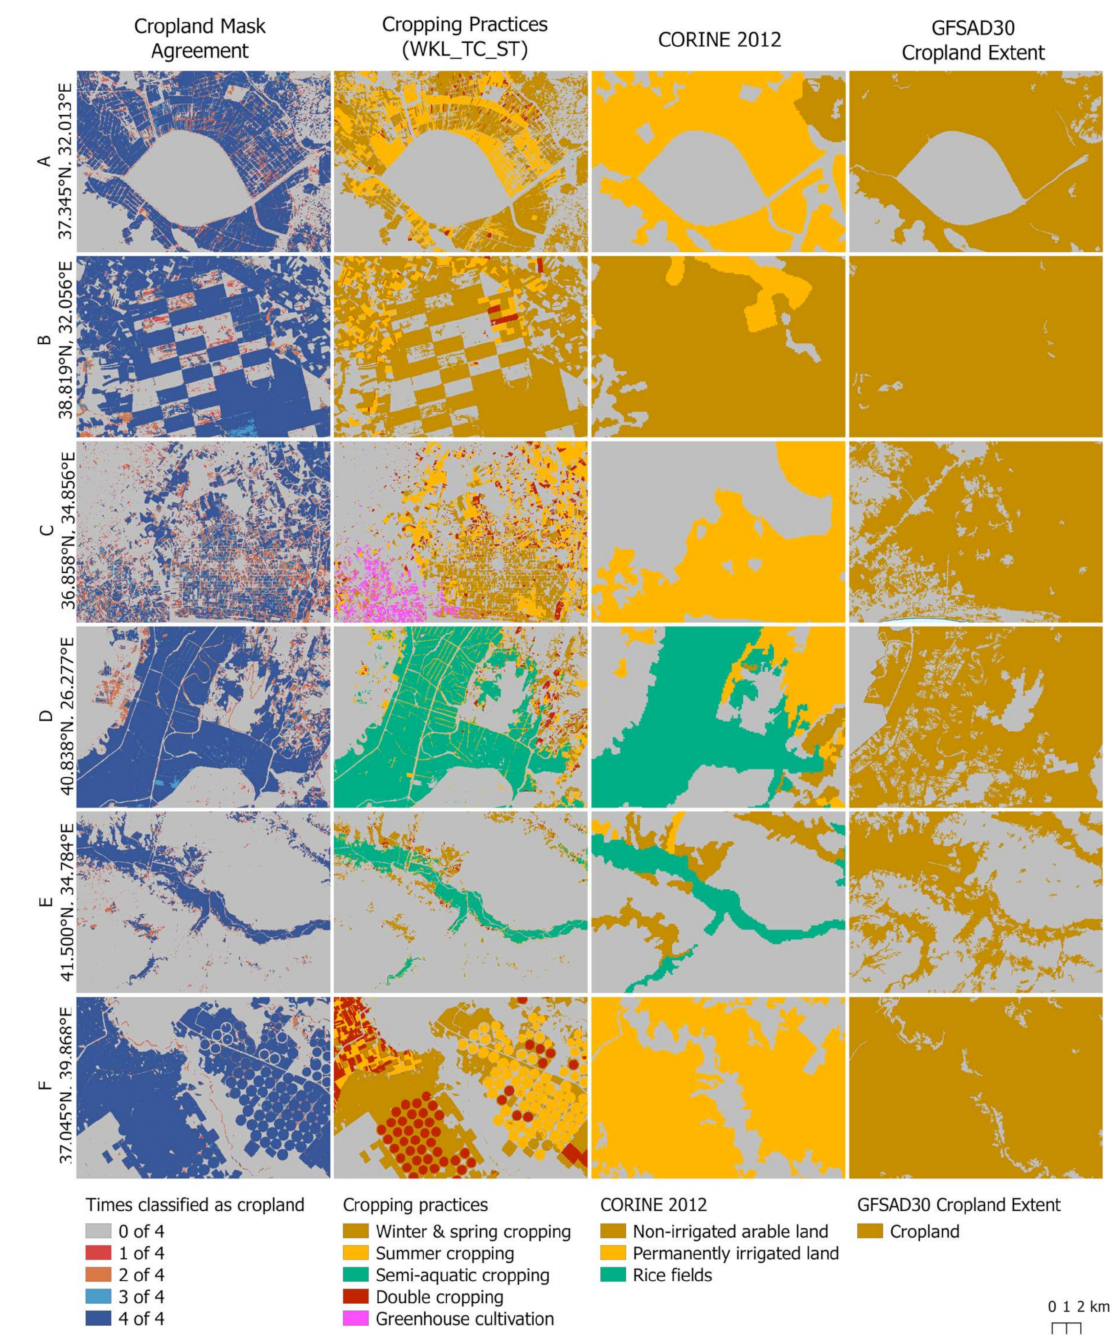
Figure 5. Image subsets (rows A to F) of cropland mask overlay (first column), cropping practice product (second column), CORINE 2012 (third column) and GFSAD30 product (fourth column). Center coordinates of each subset indicated to the